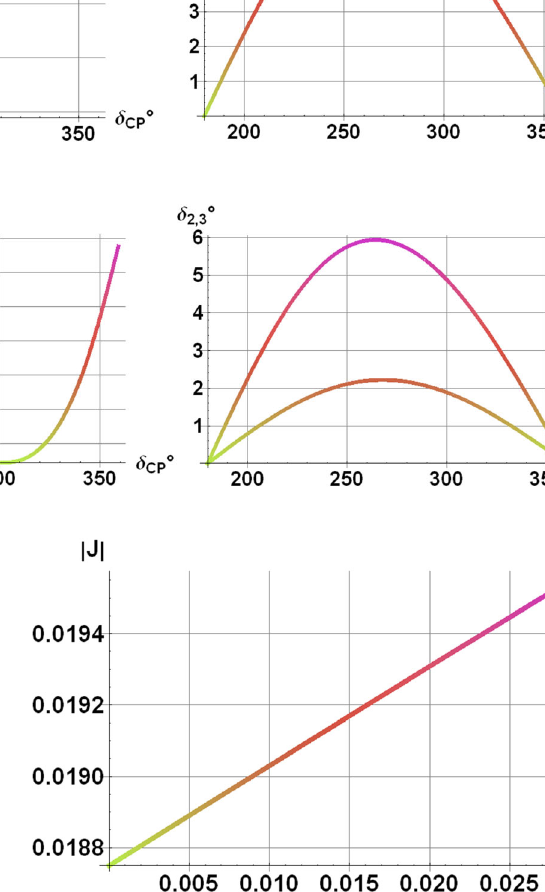
Fig. 9 Dependence of the absolute value of the Jarlskog invariant J on the imaginary diagonal parameter α in (48) The dependence of the absolute value of the